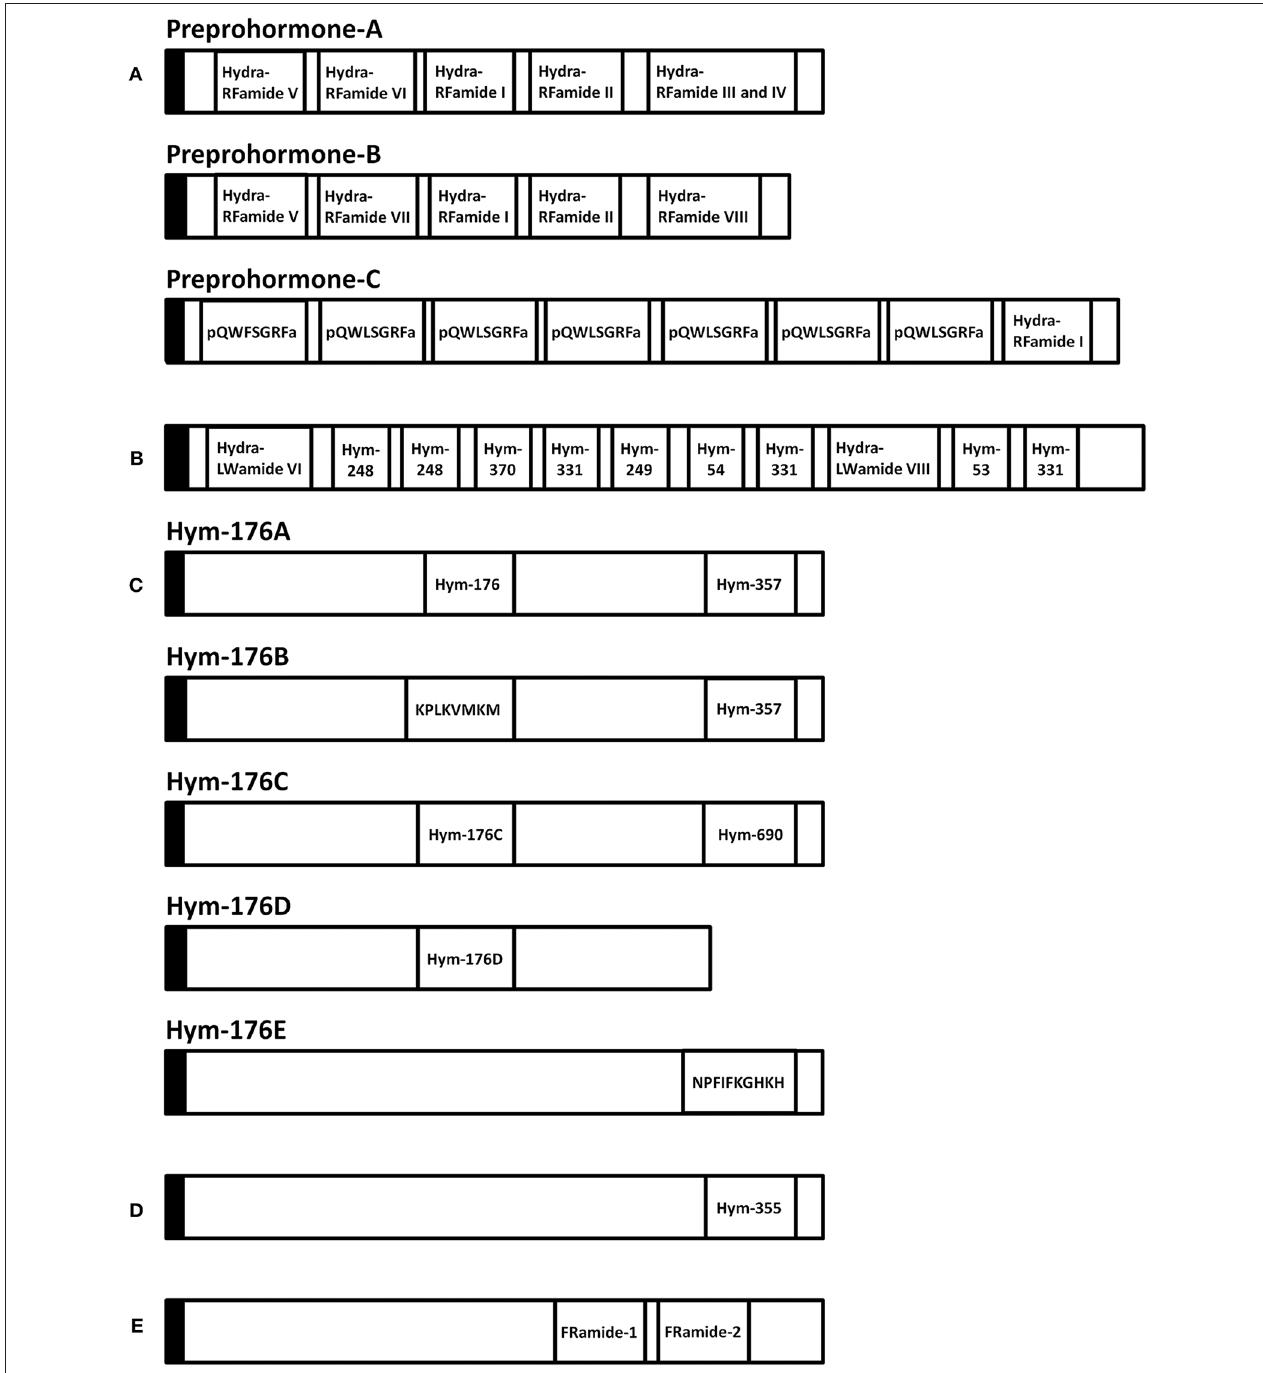
FIGURE 2 | Schematic representation of eleven preprohormones in Hydra . (A) Preprohormone-A contains unprocessed Hydra-RFamide I, II, III, IV, V, and VI. Preprohormone-B contains unprocessed Hydra-RFamide I, II, V, VII, and VIII. Preprohormone-C contains Hydra-RFamide I and two putative neuropeptide sequences (pQWFSGRFa and pQWLSGRFa). (B) The GLWamide precursor contains unprocessed GLWamides (Hym-53, 54, 248, 249, 331, and 370) and two putative neuropeptide sequences (Hydra-LWamide VI and VIII). (C) The Hym-176 precursor (Hym-176A) contains one copy of unprocessed Hym-176 and Hym-357. Hym-176B contains Hym-357 and one putative neuropeptide (KPLKVMKM). Hym-176C and Hym-176D contain one copy of Hm-176-homologous peptide (Hym-176C and Hym-176D), respectively. Hym-176C also contains one unprocessed Hym-690. Hym-176E contains one putative neuropeptide sequence (NPFIFKGHKH). (D) The Hym-355 precursor contains one unprocessed Hym-355. (E) The FRamide precursor contains unprocessed FRamide-1 and − 2. Black box: signal sequence, a: amide.